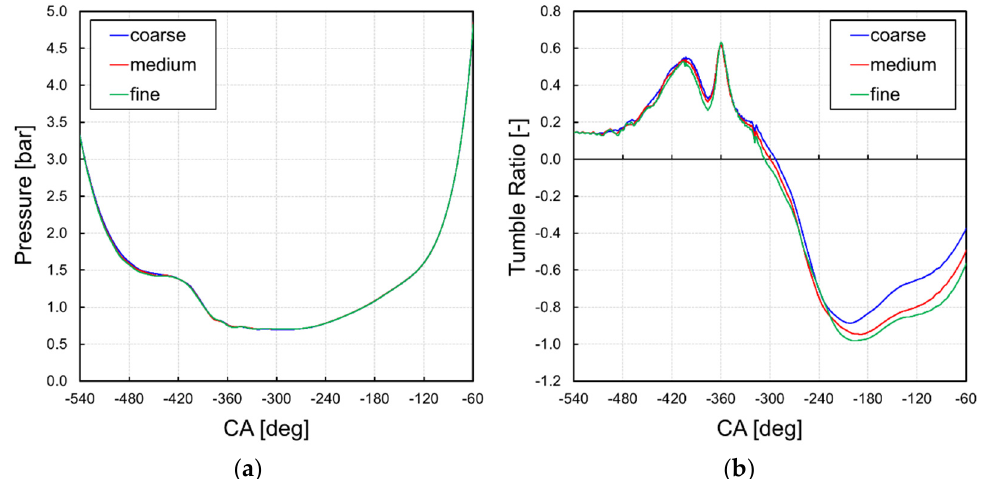
Figure 2. Mesh sensitivity results ( a ) in-cylinder pressure; ( b ) in-cylinder tumble ratio.